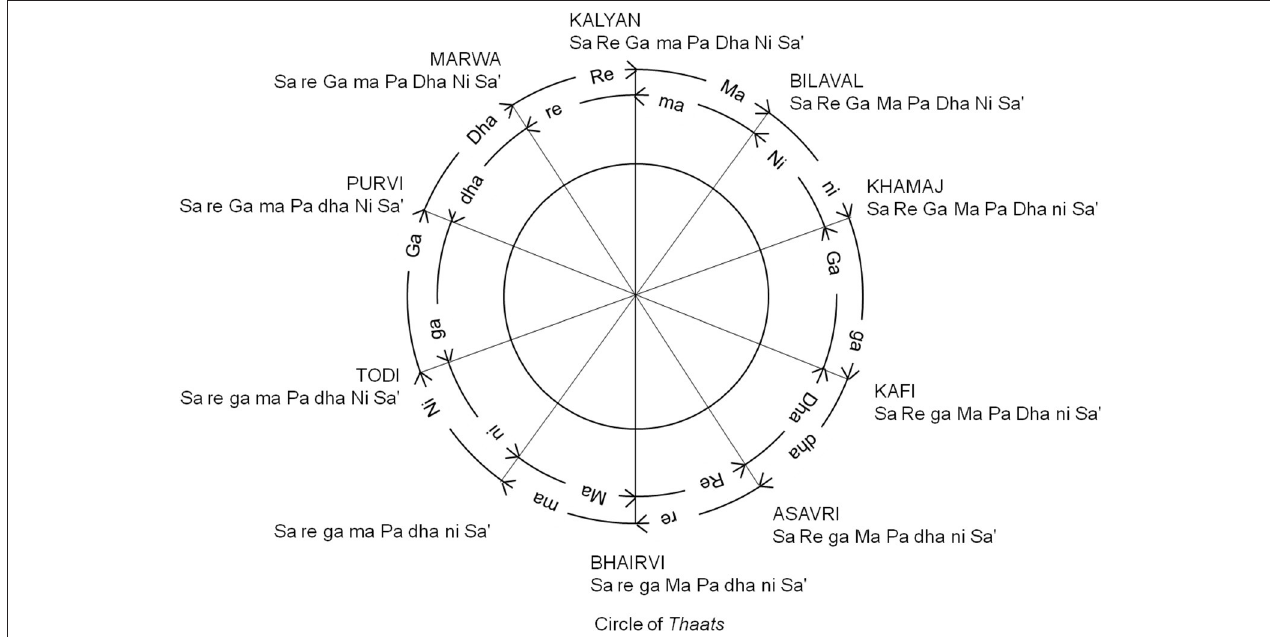
FIGURE 1 | Circle of Thaats. The circle of thaats illustrating inter- thaat distance. Nine of the ten thaats on the circle are members of Bhatkhande’s classification system ( Bhatkhande, 1934). No. 7 thaat Bhairav is not currently used in NICM. Thaat Bhairav with the scale of S r G M P d N is not represented within the circle of thaats (Adapted from Jairazbhoy, 1995, p. 59).